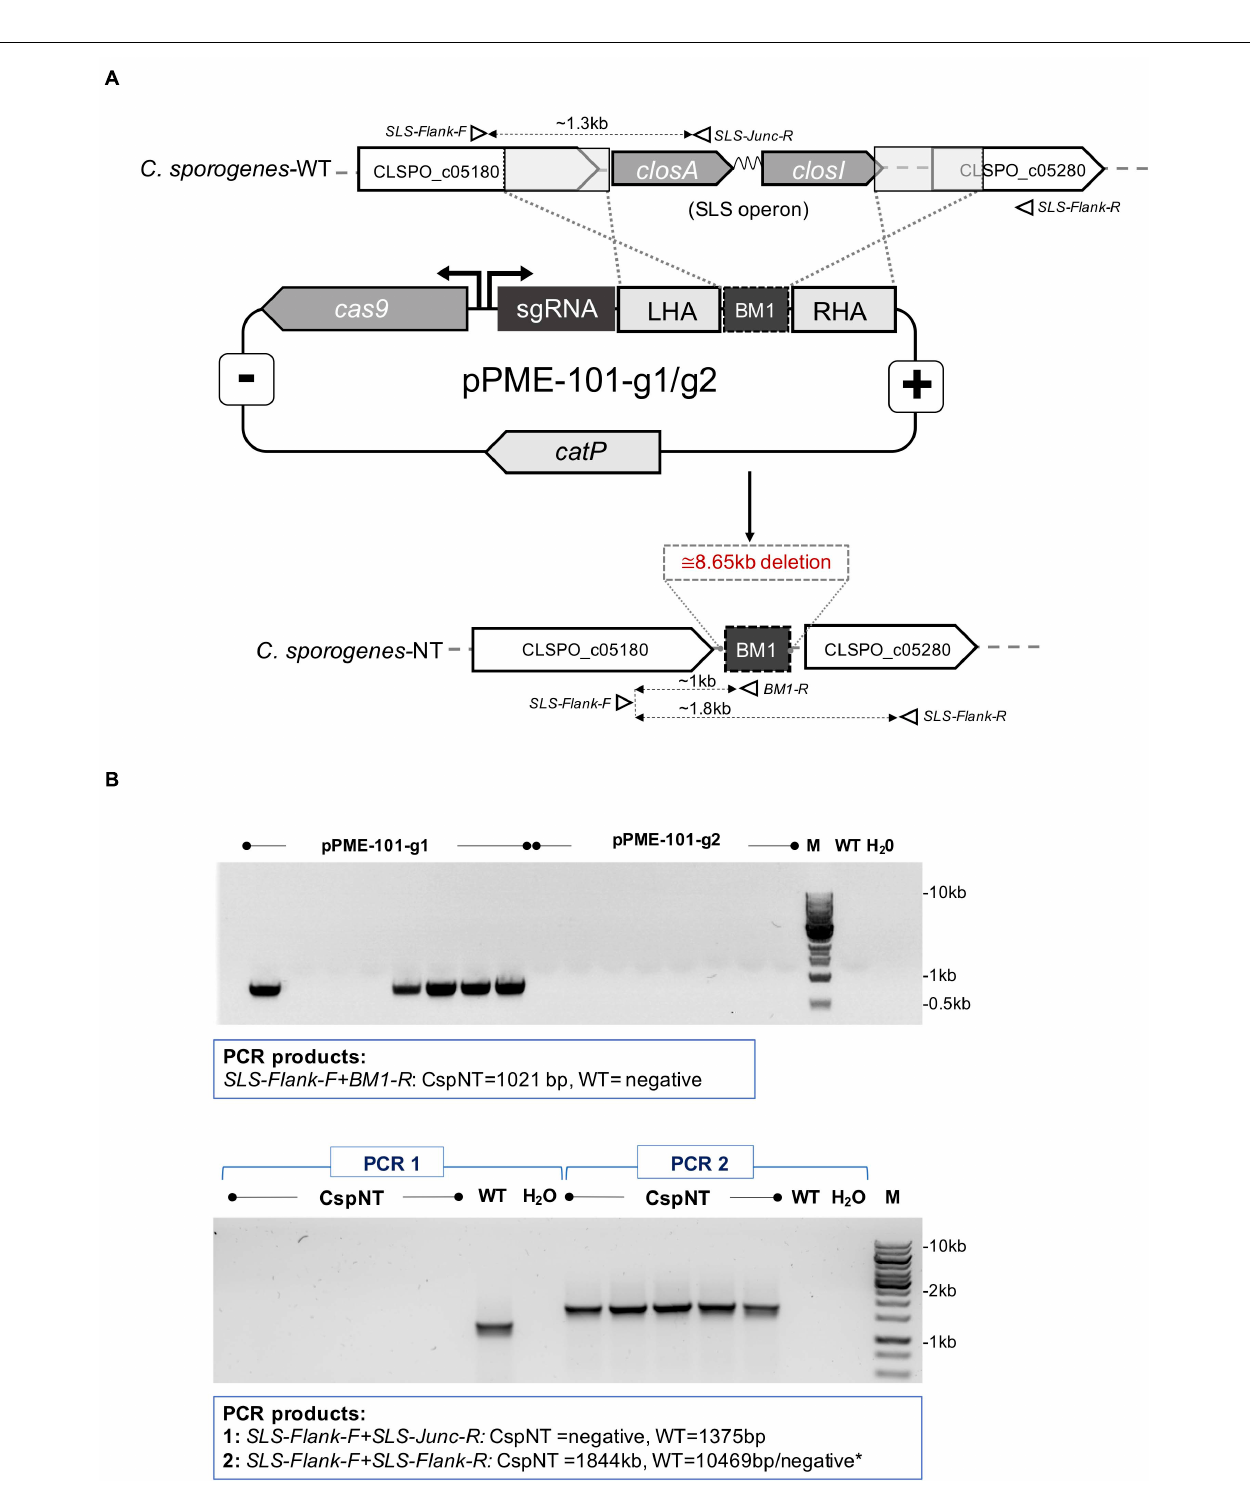
FIGURE 1 | Schematic representation of CRISPR-Cas9 mediated integration and PCR analysis of SLS operon deletion in C. sporogenes -NT strain. (A) The genome editing vectors (pPME-101-g1/g2) containing spCas9, guide RNAs and an editing template for homologous recombination at the target chromosomal locus and integration of a BM1 “bookmark” sequence. Open triangles represent indicative alignment of screening primers as presented in Supplementary Table 2 . (B) Gel electrophoresis showing a PCR screen of pPME-101-g1/g2 transconjugant colonies. Top image: Deletion of the operon detected in colonies subjected to a chromosome/bookmark-specific PCR reaction. Bottom image: Subsequent confirmation of SLS operon deletion in five selected clones. “M” denotes DNA marker,